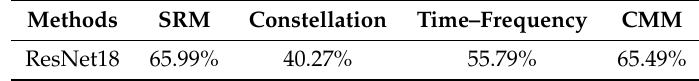
Figure 5. The performance of the radio–image transformer (RIT) methods on dataset Sig1024, compared with the constellation diagram method and time–frequency image method. Table 3. Comparison of the overall classification accuracy of the four methods. The dataset is Sig1024.